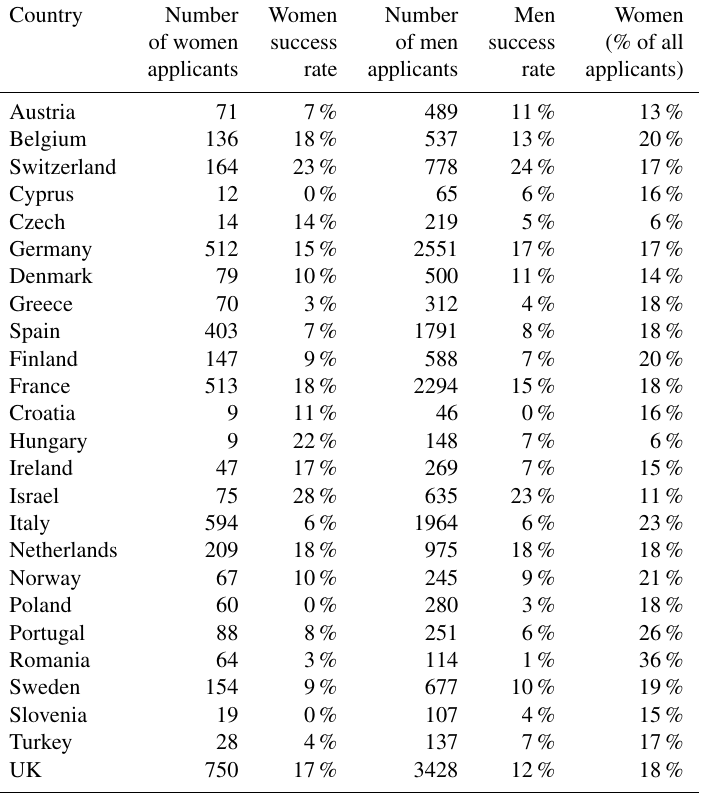
Table A1. Country-specific numbers of applications from women and men to the PE panel at the ERC (2012–2018), the success rates and the proportion of women among all applicants (%). Only countries with at least 50 applications during this time period are included in the table. Source: European Research Council, https://erc.europa.eu/sites/default/files/publication/files/ERC_funding_activities_2007_2013.pdf (last access: 4 June